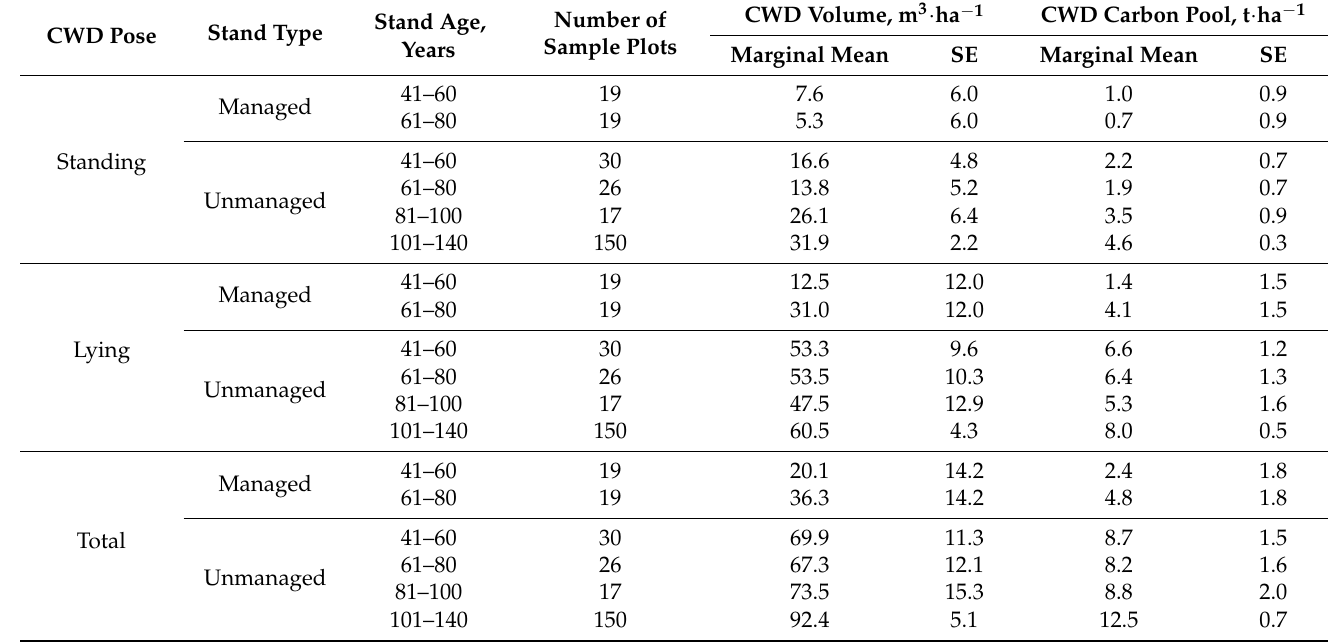
Table 4. Coarse woody debris (CWD) volume and CWD carbon pool size in mature (41–60 years), moderately overmature (61–80 years), overmature (81–100 years), and old-growth (101–140 years) European aspen ( Populus tremula L.) stands by CWD pose and stand type.